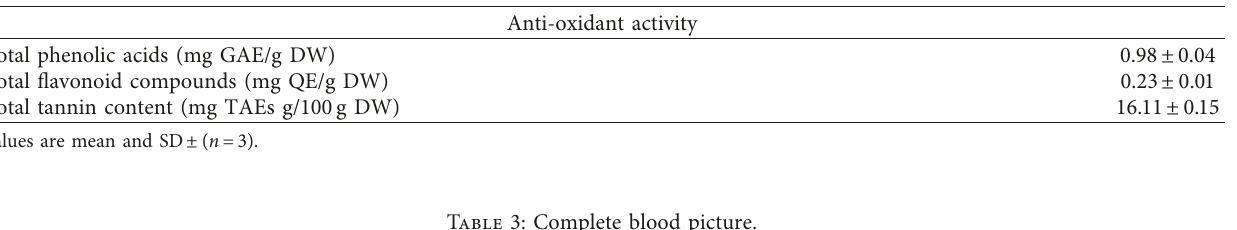
Table 2: Anti-oxidant profile in chia seeds.